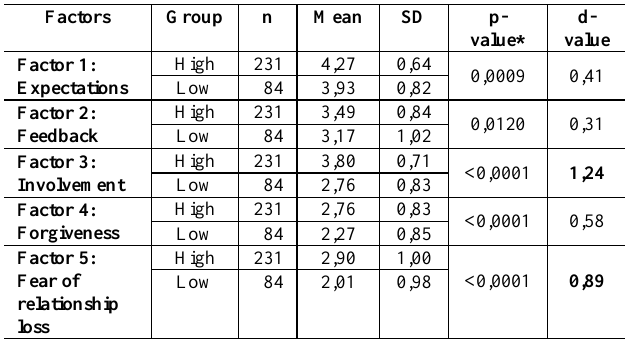
Table 3: Relationship intention scored for high and low relationship intention respondents